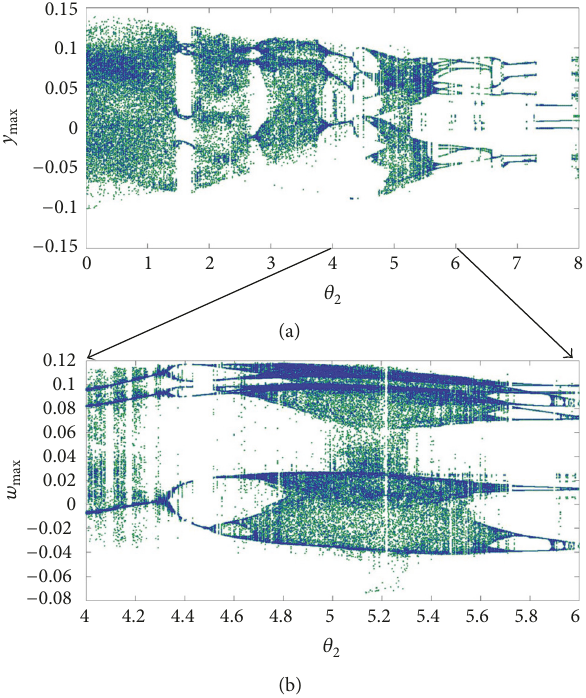
Figure 6: (a) Bifurcation of the FO2DOFSMA oscillator with parameter 𝜃 2 with 𝑞 = 0.99 and 𝜃 1 = 𝜃 2 = 1.5 . The initial conditions for are taken as [0,0,0,1] and are reinitialized in end of each iteration to the final values of the state variables. (b) shows the zoomed in view of (a) between 4 ≤ 𝜃 2 ≤ 6